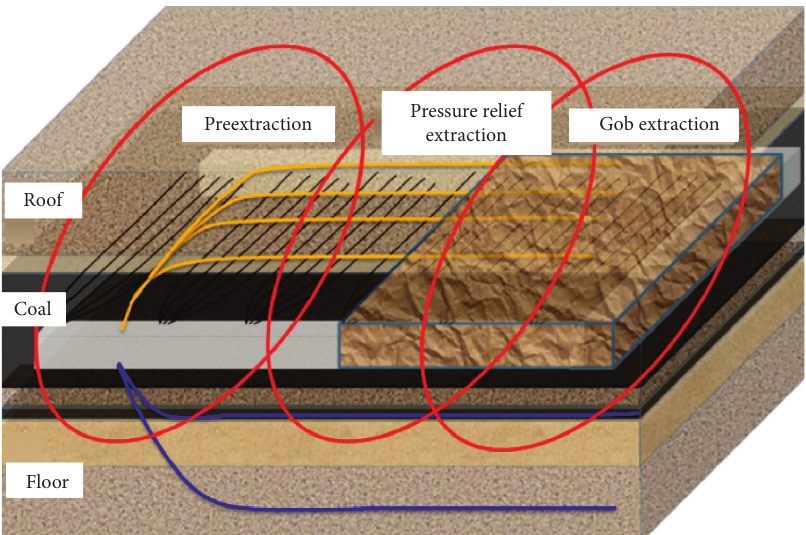
Figure 1: Coal, oil, and gas symbiotic mine three-dimensional comprehensive extraction